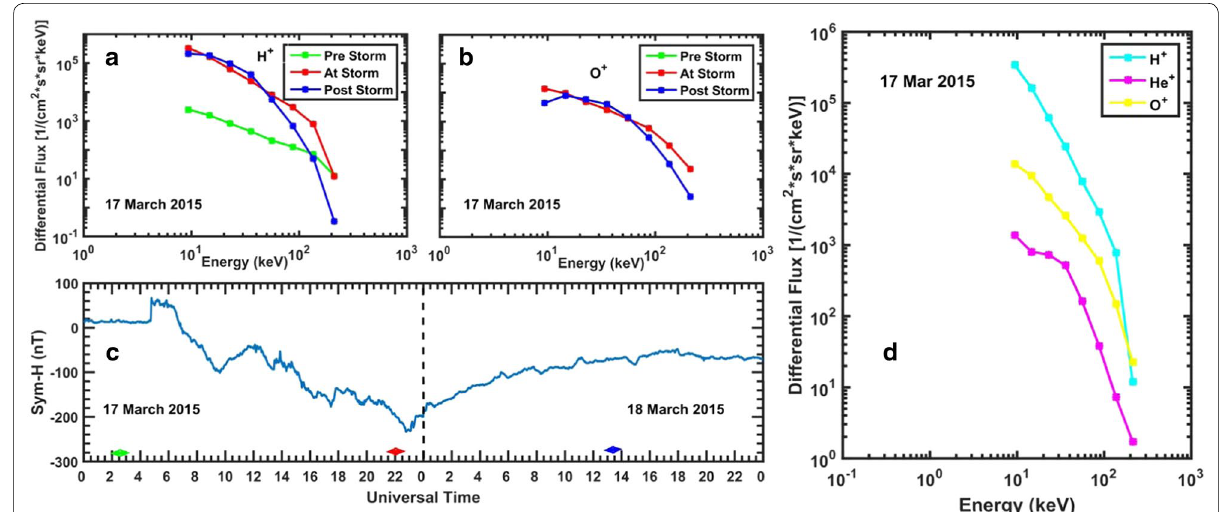
Fig. 5 Same as Fig. 4 using Geotail observations, except for 17 March 2015 storm having pre-storm interval 0200–0300 UT, post-storm interval 1200–1300 UT and main phase at 2150–2250